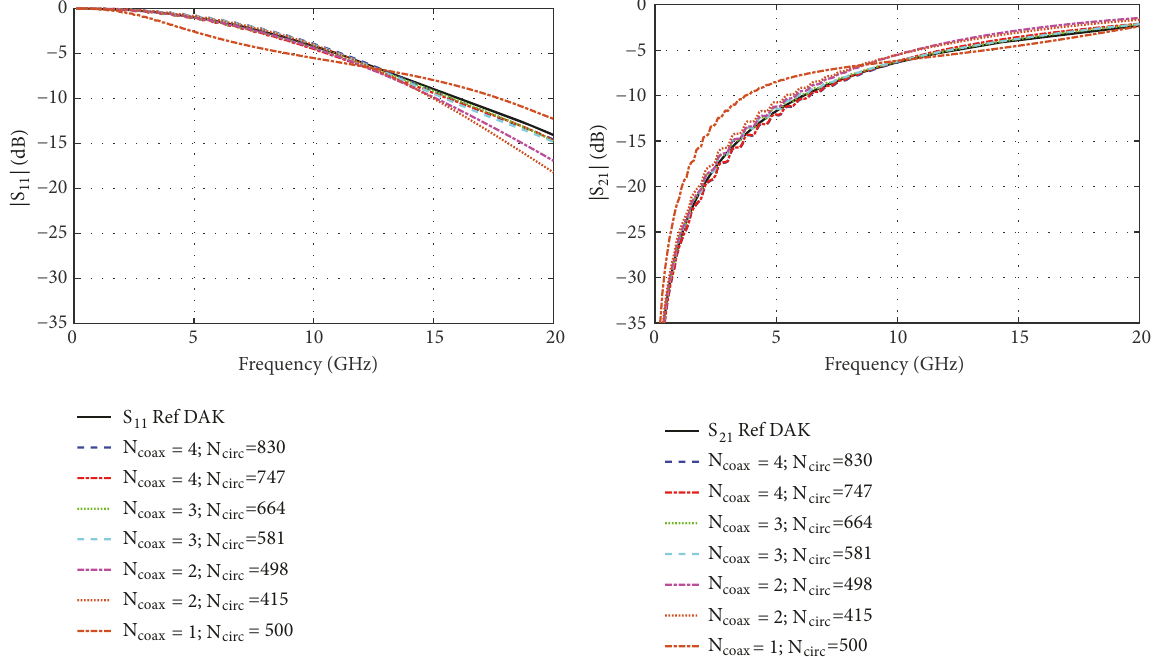
modes at the input/output coaxial lines, n =200b). sample